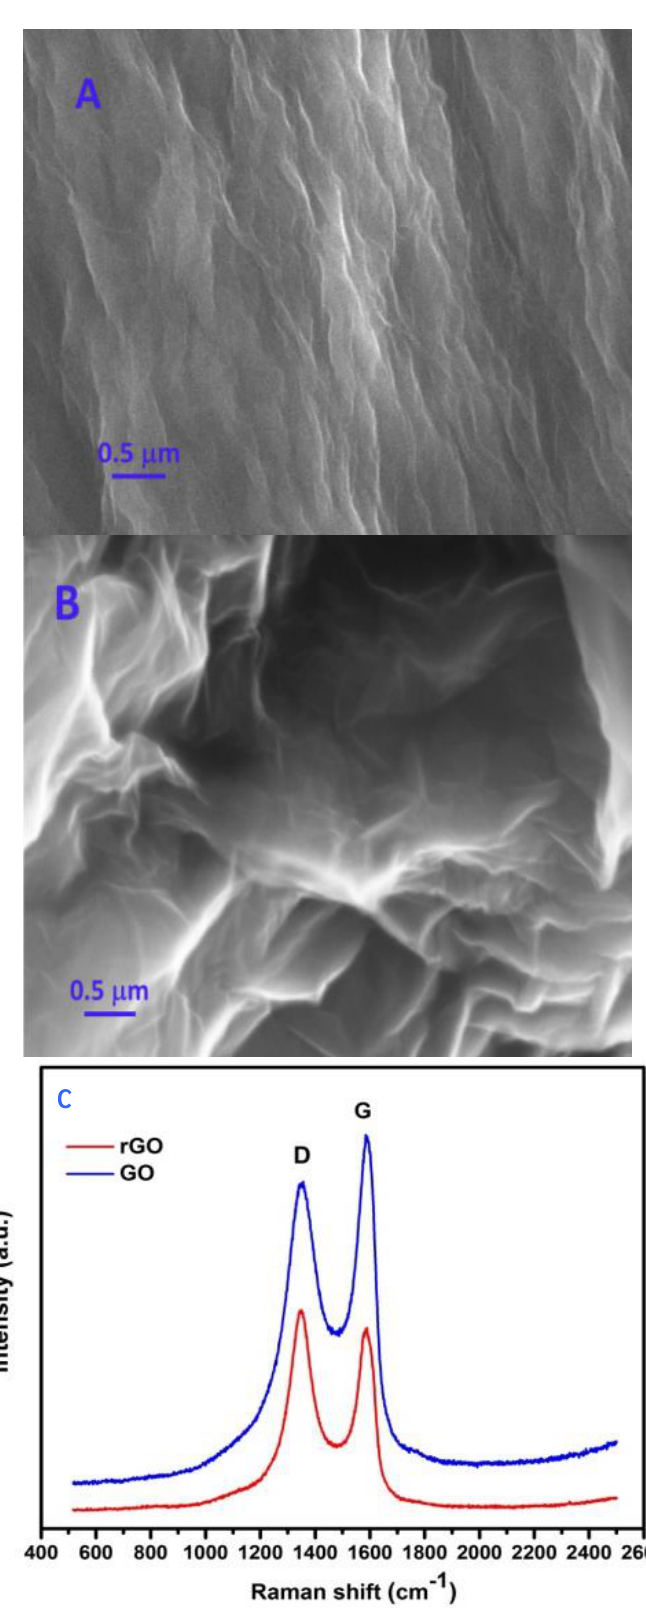
Figure 1. Typical FESEM images obtained for GO ( A ) and rGO ( B ) and their Raman spectra ( C ). TG curve obtained for the as-obtained chromia, i.e., the un-calcined Cr 2 O 3 .4H 2 O, displays two main decomposition steps, as shown in Figure 2. The first step is shown to undertake about a 25% mass loss maximized at 237 °C. This process is consistent with the removal of weakly held water